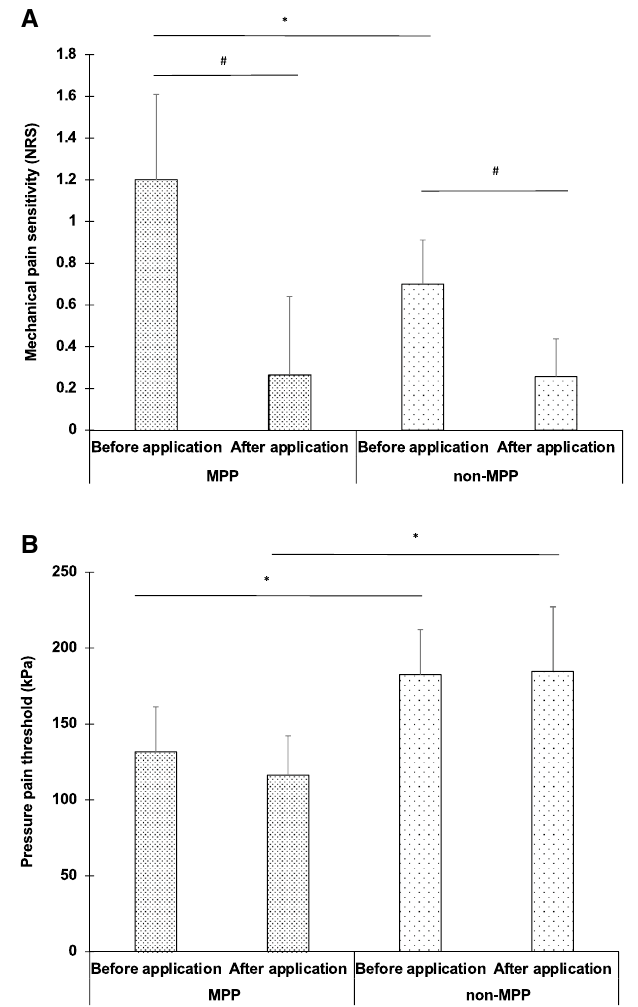
Figure 3. Comparison of MPS on Masseter muscle between before lidocaine application than after lidocaine application in the MPP and non-MPP groups ( A ), Comparison of PPT on Masseter muscle between before lidocaine application than after lidocaine application in the MPP and non-MPP groups ( B ). MPS on the masseter muscle was significantly higher in the MPP group than in the non-MPP group (*P < 0.05, Tukey post hoc test). In both the MPP and non-MPP groups, the MPS on the masseter muscle was significantly higher before lidocaine application than after lidocaine application ( # P < 0.05, Tukey post hoc test). PPT